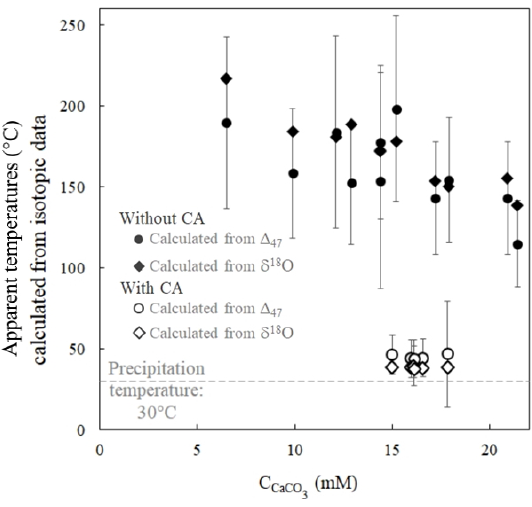
Figure 4. δ 18 O carbonate and (cid:49) 47 disequilibria in microbial carbon- ates induce comparable biased estimates of precipitation tempera- ture as illustrated by apparent temperatures calculated from the car- bonate δ 18 O carbonate and (cid:49) 47 signatures as a function of CaCO 3 accumulation. Open and solid symbols refer to the experiments with and without CA, respectively. The dashed grey line corresponds to the actual precipitation temperature. Apparent temperatures are re- spectively calculated from the δ 18 O carbonate and (cid:49) 47 calibrations to the temperature of Kim and O’Neil (1997) and Bonifacie et al. (2017). Reported uncertainties were calculated as the propaga- tion of the 1 standard deviation (1SD) error of the isotopic data in the calibration equations (Sect. 2 and Sect. S1 in the Supplement).